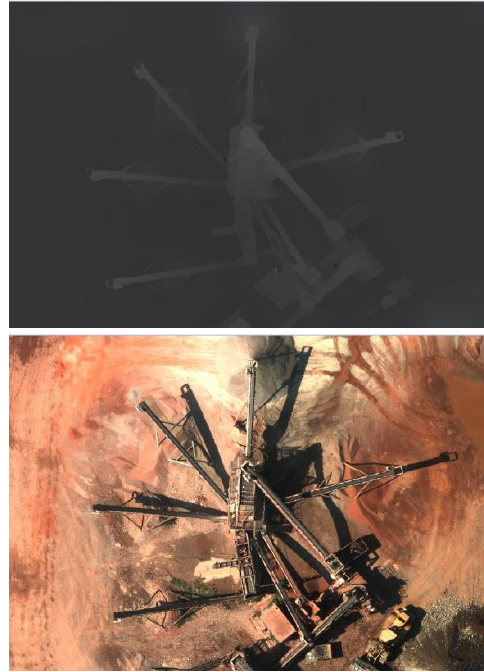
Figure 6 DSM and DSMOrtho screenshot showing a gravel pit (data courtesy of City of Graz).